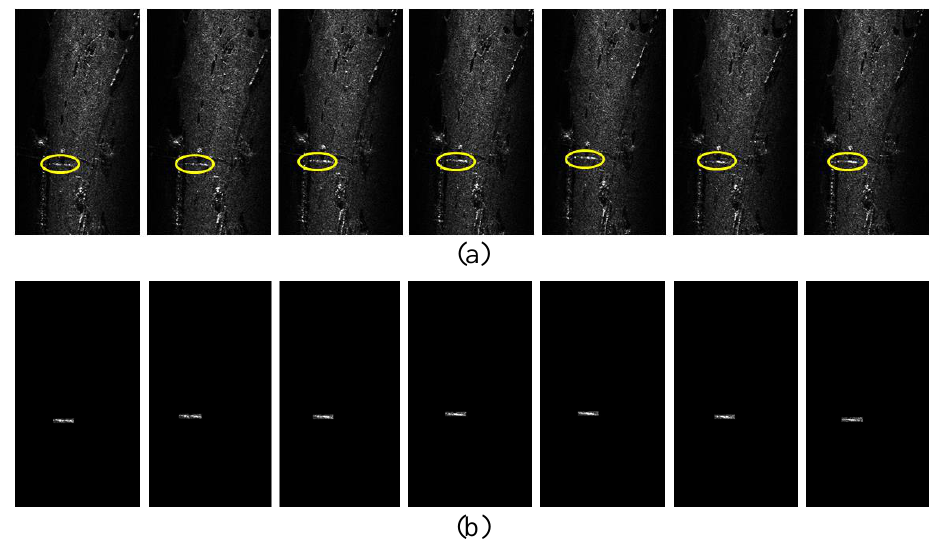
Figure 18. The stationary scene containing moving target T4.